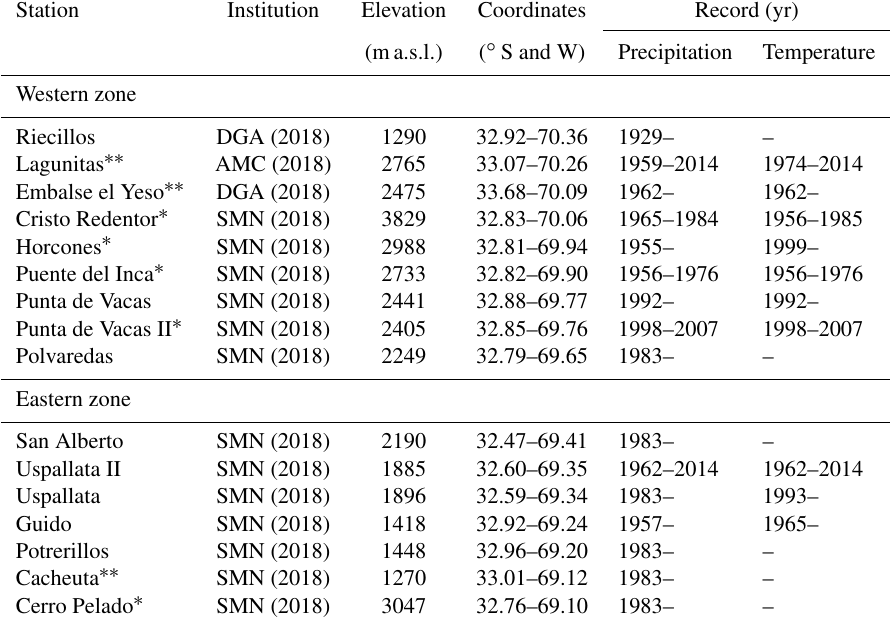
Table 1. Stations used and their main characteristics. The registration period does not consider interruptions. The stations without asterisks were used for trigger determination and statistical analysis, and those with one (two) asterisks were used only for trigger determination (statistical